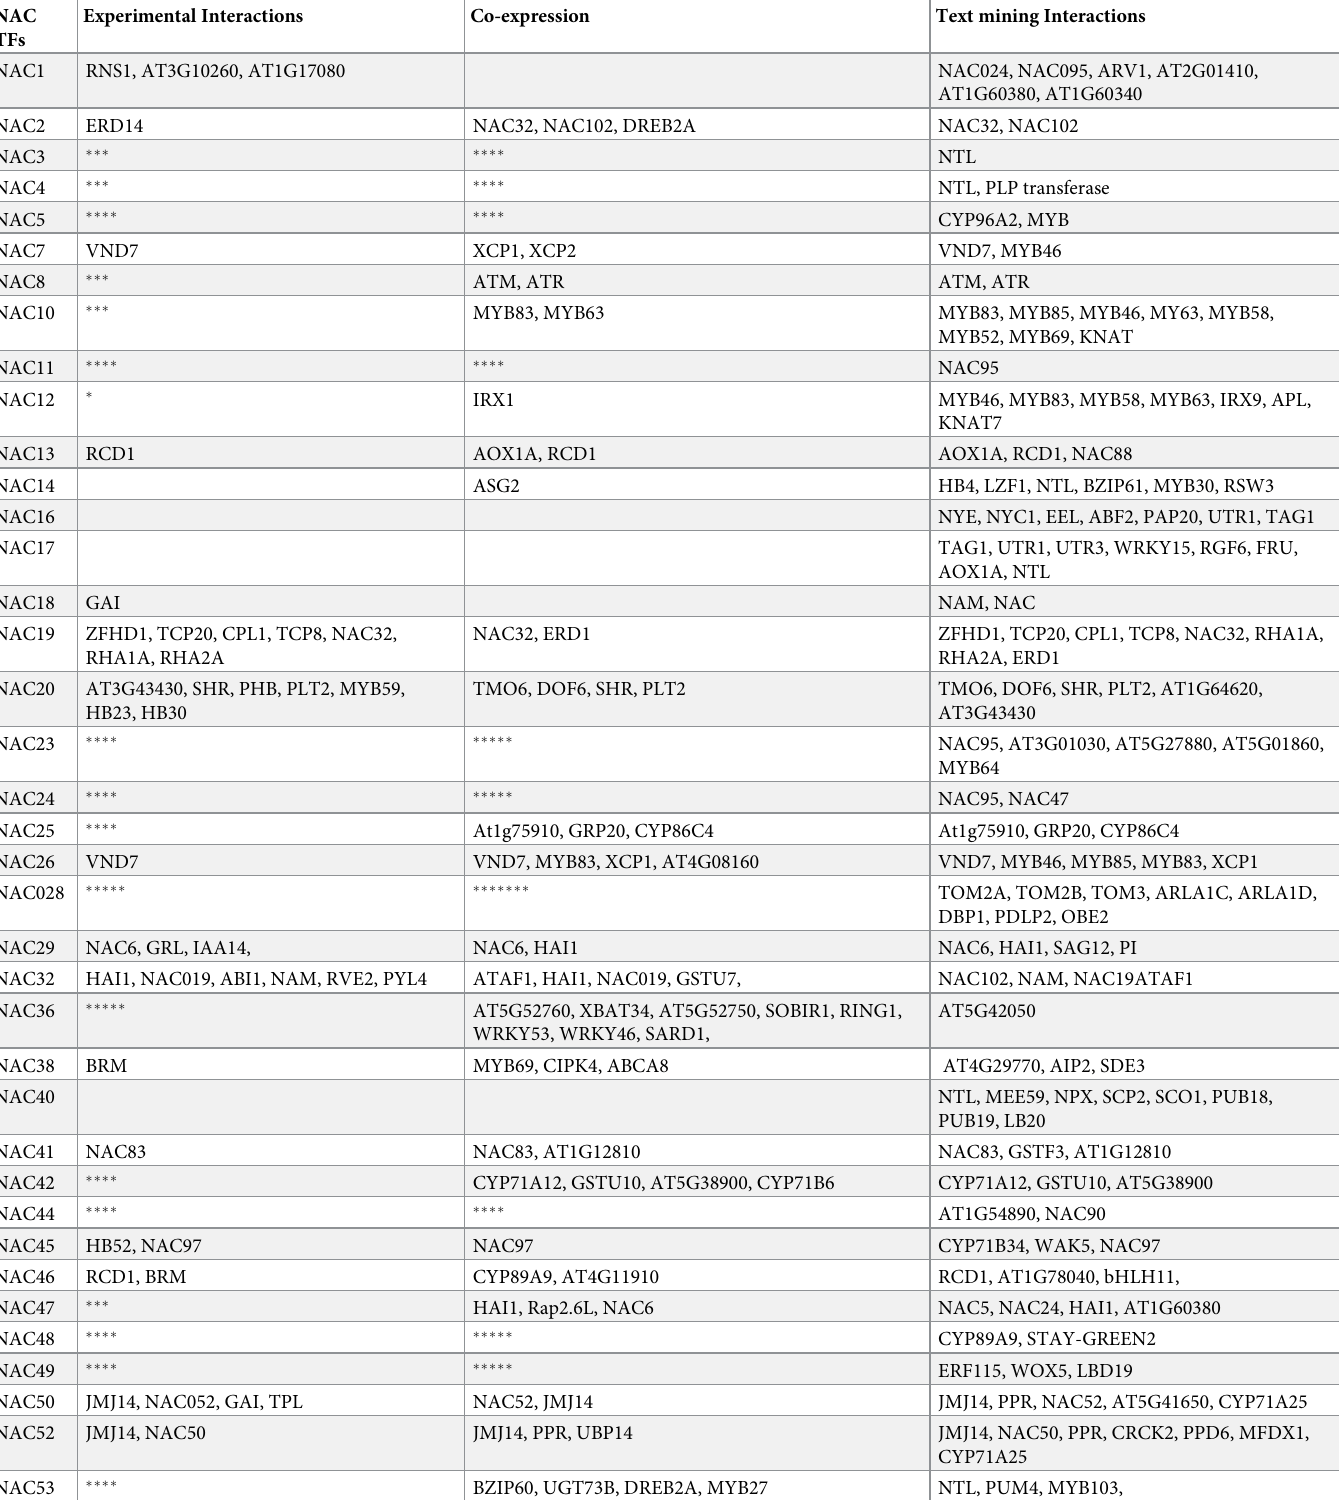
Table 3. Interacting partners of NAC TFs in plants. A . thaliana NAC TFs was used to construct the interactome network. Asterisk indicates no interaction. NAC